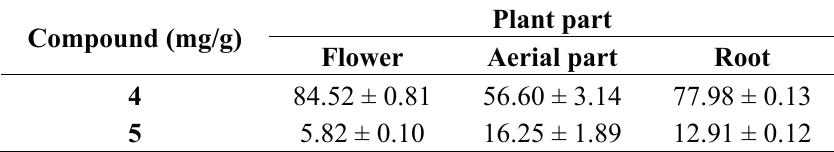
Table 3. The average contents of compounds 4 and 5 from different parts of A. oleracea